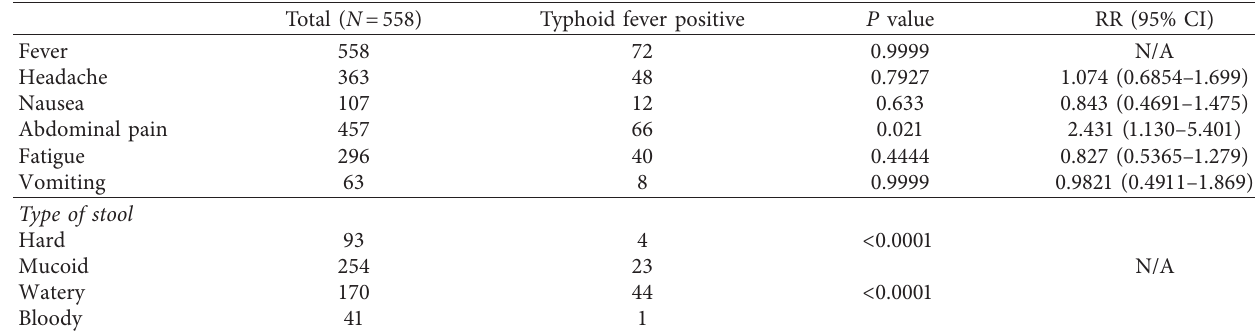
Table 3: Distribution of clinical symptoms of study